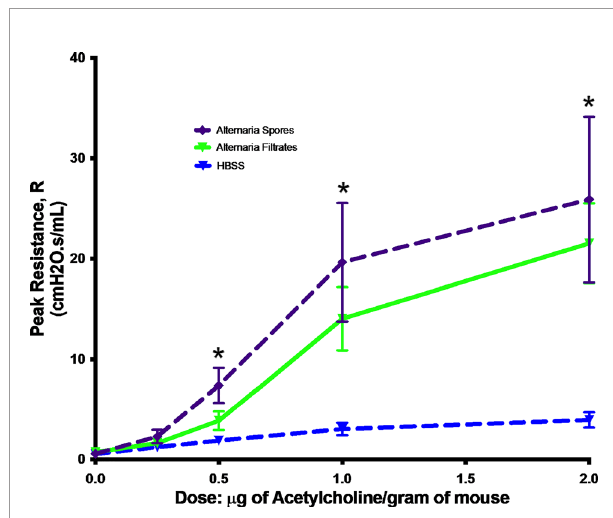
FIGURE 1 | Alternaria -induced AHR. Mice were exposed to Alternaria fi ltrates, spores, or HBSS controls. Peak resistance after methacholine challenge was presented as Mean ± SEM, n = 8/group. *P <